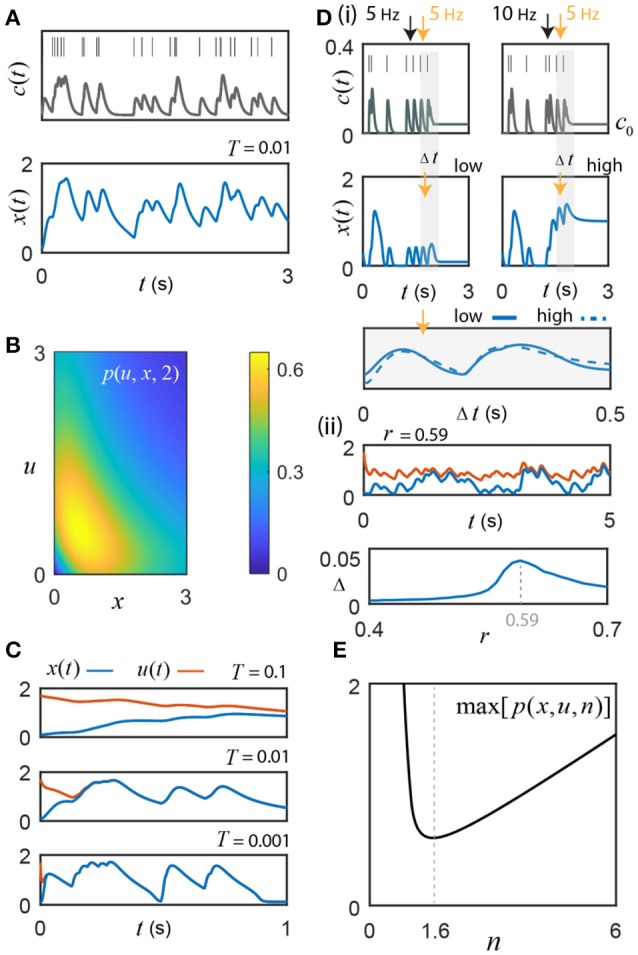
Switch activity fluctuates with instantaneous input frequency. (A) Motivating example: switch response to an 8 Hz Poisson sequence of input pulses, convolved with an alpha function kernel to create a signal, c(t) = c0+cl(t). The switch's fluctuations track changes in the input frequency (n = 1.6, r = 0.61, c0 = 0.04, and T = 0.01). (B) The example function p(u, x, 2) from the uniqueness proof achieves a maximum of 0.65; r must exceed this value to guarantee absolute convergence of the switch to a unique frequency-driven solution. (C) Initial conditions: u(0) = 1.7 and x(0) = 0.1. The value of T affects time-to-convergence between solutions and frequency filtering. From empirical studies, T ≤ 0.01 (Coultrap and Bayer, 2012). (D) (i) For r = 0.54 < rc, sufficiently high frequency Ca2+ pulses (bursts) cause transitions from the low to high state (illustrated for n = 2). By adjusting c0 to take advantage of hysteresis, the cell can control whether or not it is sensitive to these burst-induced up states. The first two pulses (< 10 Hz), where c0 = 0, do not result in hysteresis, whereas the high frequency 10 Hz inter-pulse interval (right panel black arrow) with c0 augmented to 0.04 does; note that neither static value can generate the upstate alone without sufficient input (e.g., 5 Hz, left panel black arrow). The switch response differs during the transition between low and high states, but once settled around a given state gives good agreement (gray shading; the two example curves are compared by choosing an offset of 0.92 that minimizes the Euclidean distance between them). (ii)
Top Simulation for r = 0.59 and n = 2, where x(t) has c0 = 0.02 and thus cannot support bistability, vs. u(t) with c0 = 0.04, which, when driven by input, traps the solutions around the high activation state through hysteresis. Under these conditions, convergence cannot occur. Bottom The absolute value of the difference between the relative changes in u(t) and x(t) induced respectively by the common input frequencies (Δ, see Results for details) plotted as a function of r; the maximum discrepancy of 0.046 is found at r = 0.59 and represents a small fraction of the total activated switch concentration. (E) In general, the exponent n≠2 in real biological systems. Interestingly, n = 1.55 is a minimum for the maximum value of the class of functions p(u, x, n) in the uniqueness proof. This is remarkably close to the empirical best-fit value of 1.6 their ± SEM or SD reported by De Koninck and Schulman for presynaptic α CaMKII (De Koninck and Schulman, 1998).